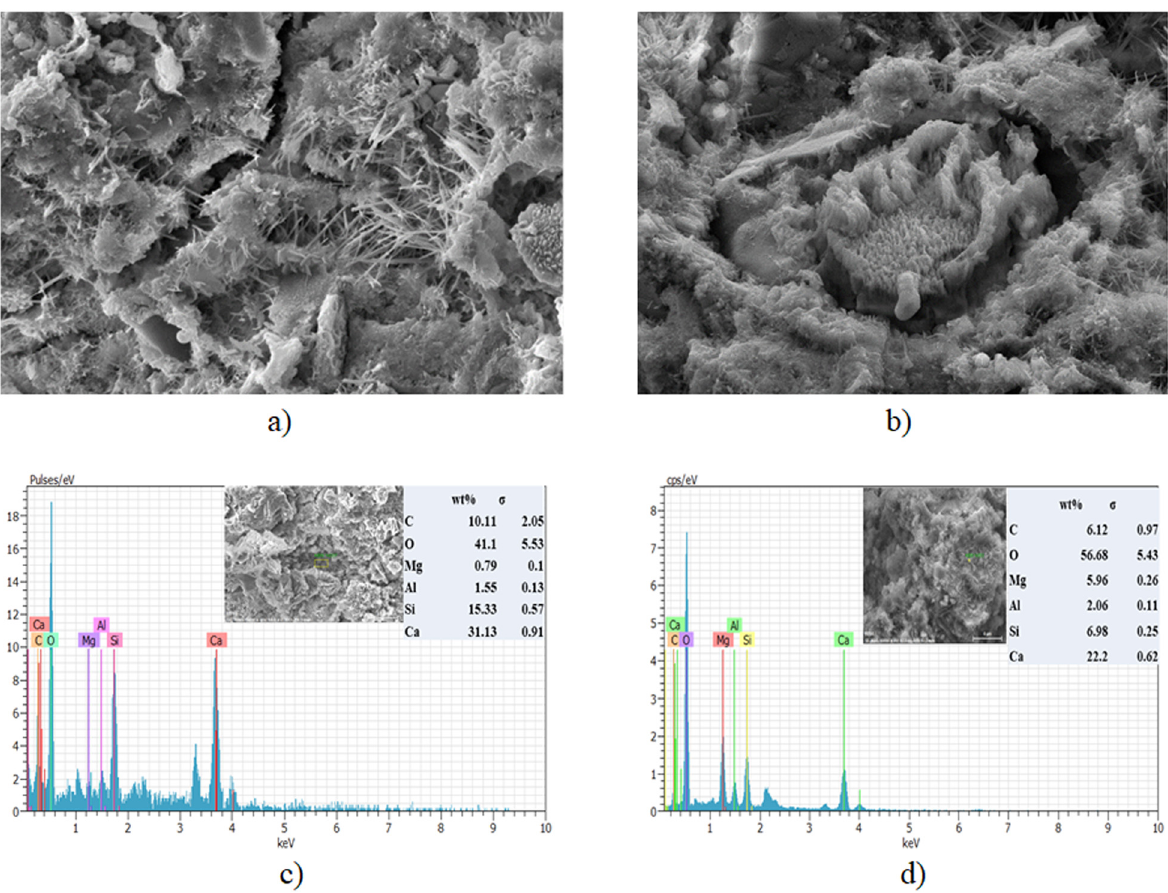
Figure 12: SEM and energy dispersive spectroscopy ( EDS ) of G0 - 0.1 and 0.2 at 28 days: ( a ) SEM GO - 0.1, ( b ) SEM GO - 0.2, ( c ) EDS GO - 0.1, and ( d ) EDS GO -